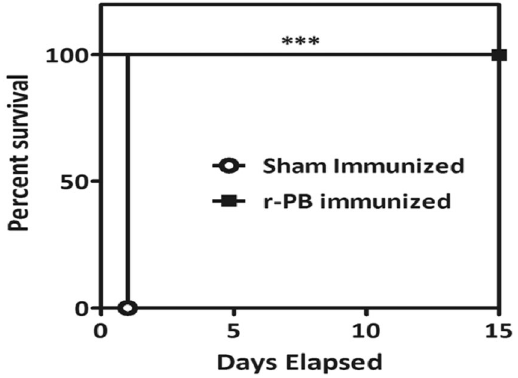
Figure 7. Passive protection of mice against B. anthracis crude toxin. Survival percentages of naive female BALB/c mice (n = 6 each group) injected i.p. with concoction of crude anthrax toxin and anti-r-PB over 15 days observation period. Control groups of mice received similar mixtures in polysera from sham immunized mice. Survival percentages were calculated by Kaplan-Meier’s method and was statistically significant (p *** ).